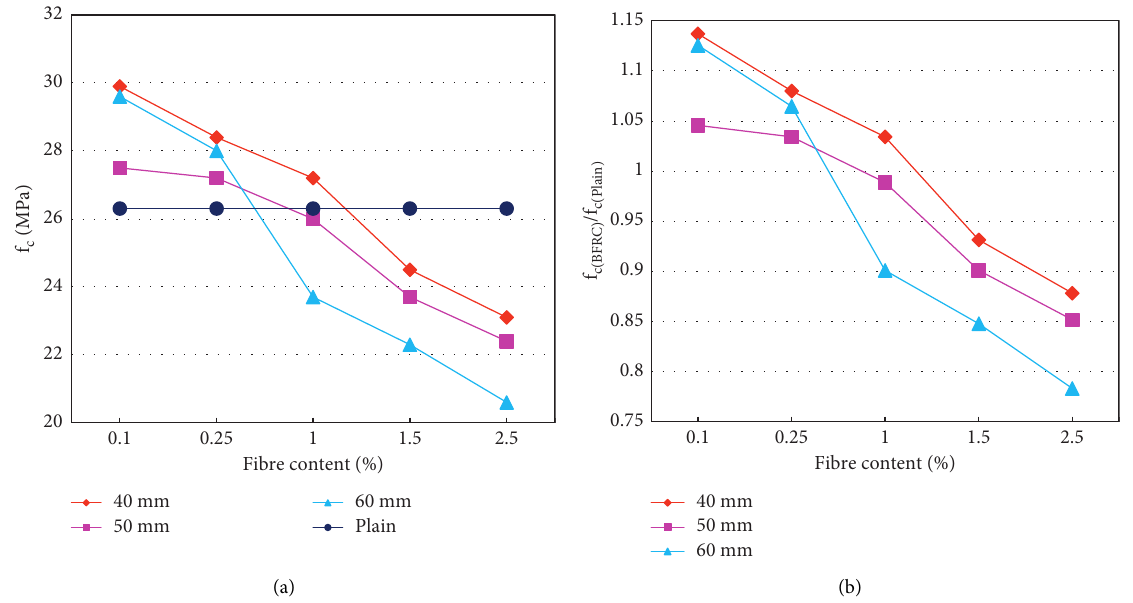
Figure 9: Effect of fibre length and fibre content on compressive strength of concrete. (a) Compressive strength. (b) Compressive strength reinforced